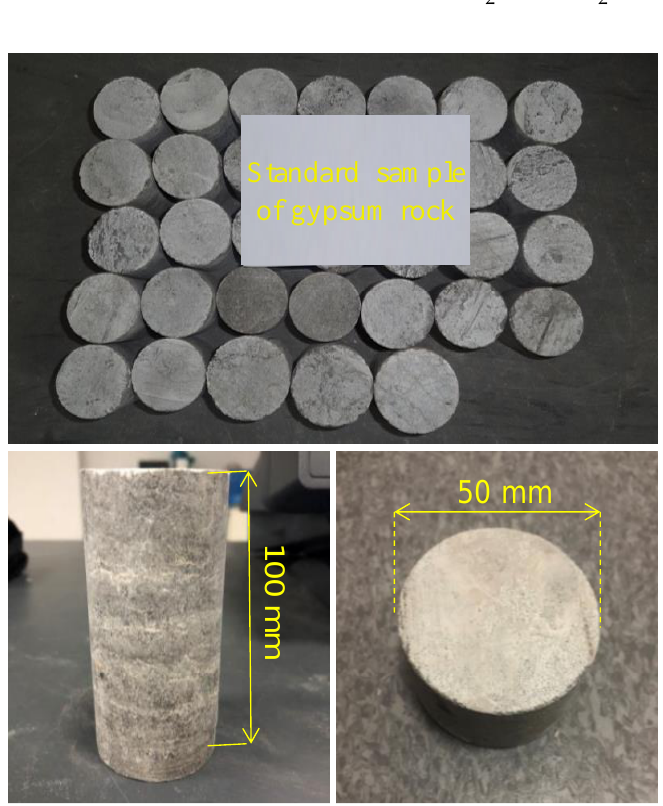
Figure 1. A standard sample of gypsum rock. Water damages the mechanical properties of gypsum rock by a range of physical and chemical actions such as hydration reaction, water adsorption, and dissolution [1,12].